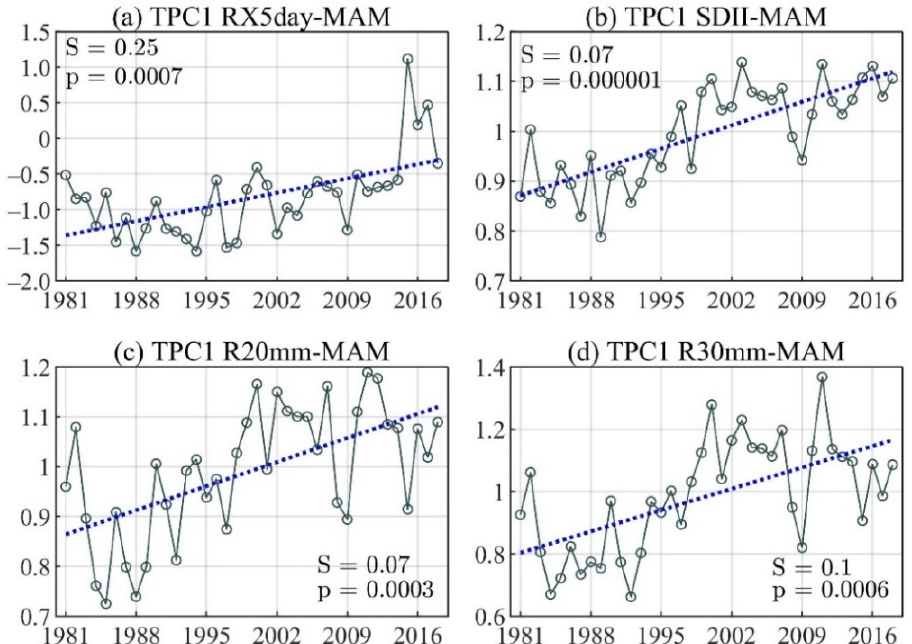
Figure 6. The linear trend of the principal component time series for the first TEOF mode of ( a ) Max 5-day precipitation amount (RX5day), ( b ) Simple daily intensity index Number (SDII), ( c ) Number of days with precipitations above R20mm (R20mm), and ( d ) Number of days with precipitations above R30mm (R30mm) during the March–May (MAM) season.